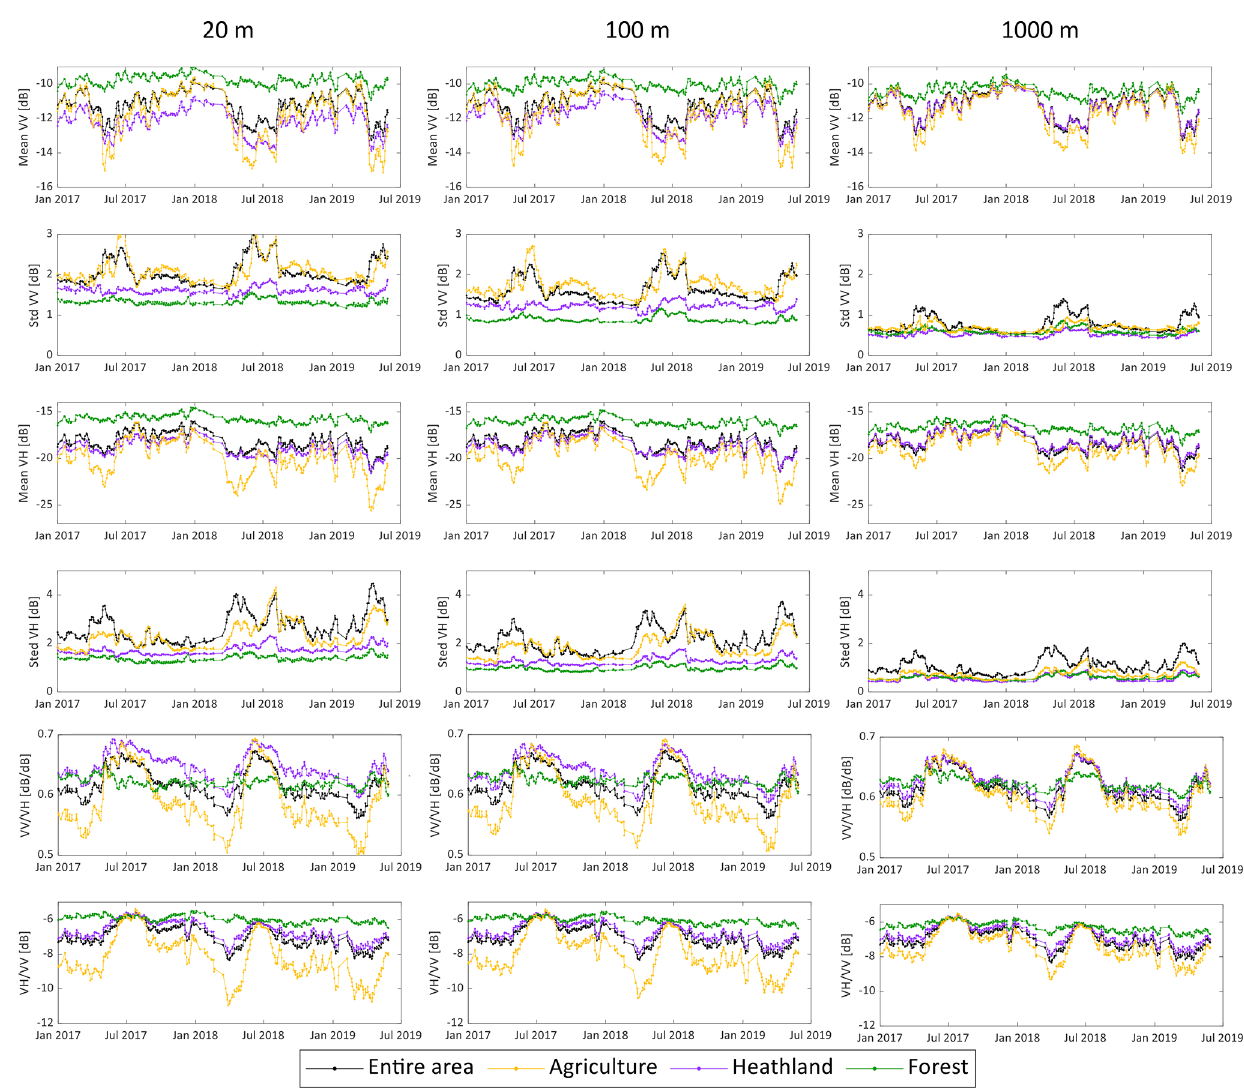
Figure 5. Temporal dynamics of mean and standard deviation of VV, VH and the two cross-ratios VV / VH and VH / VV for the different clusters at spatial resolutions of 20, 100 and